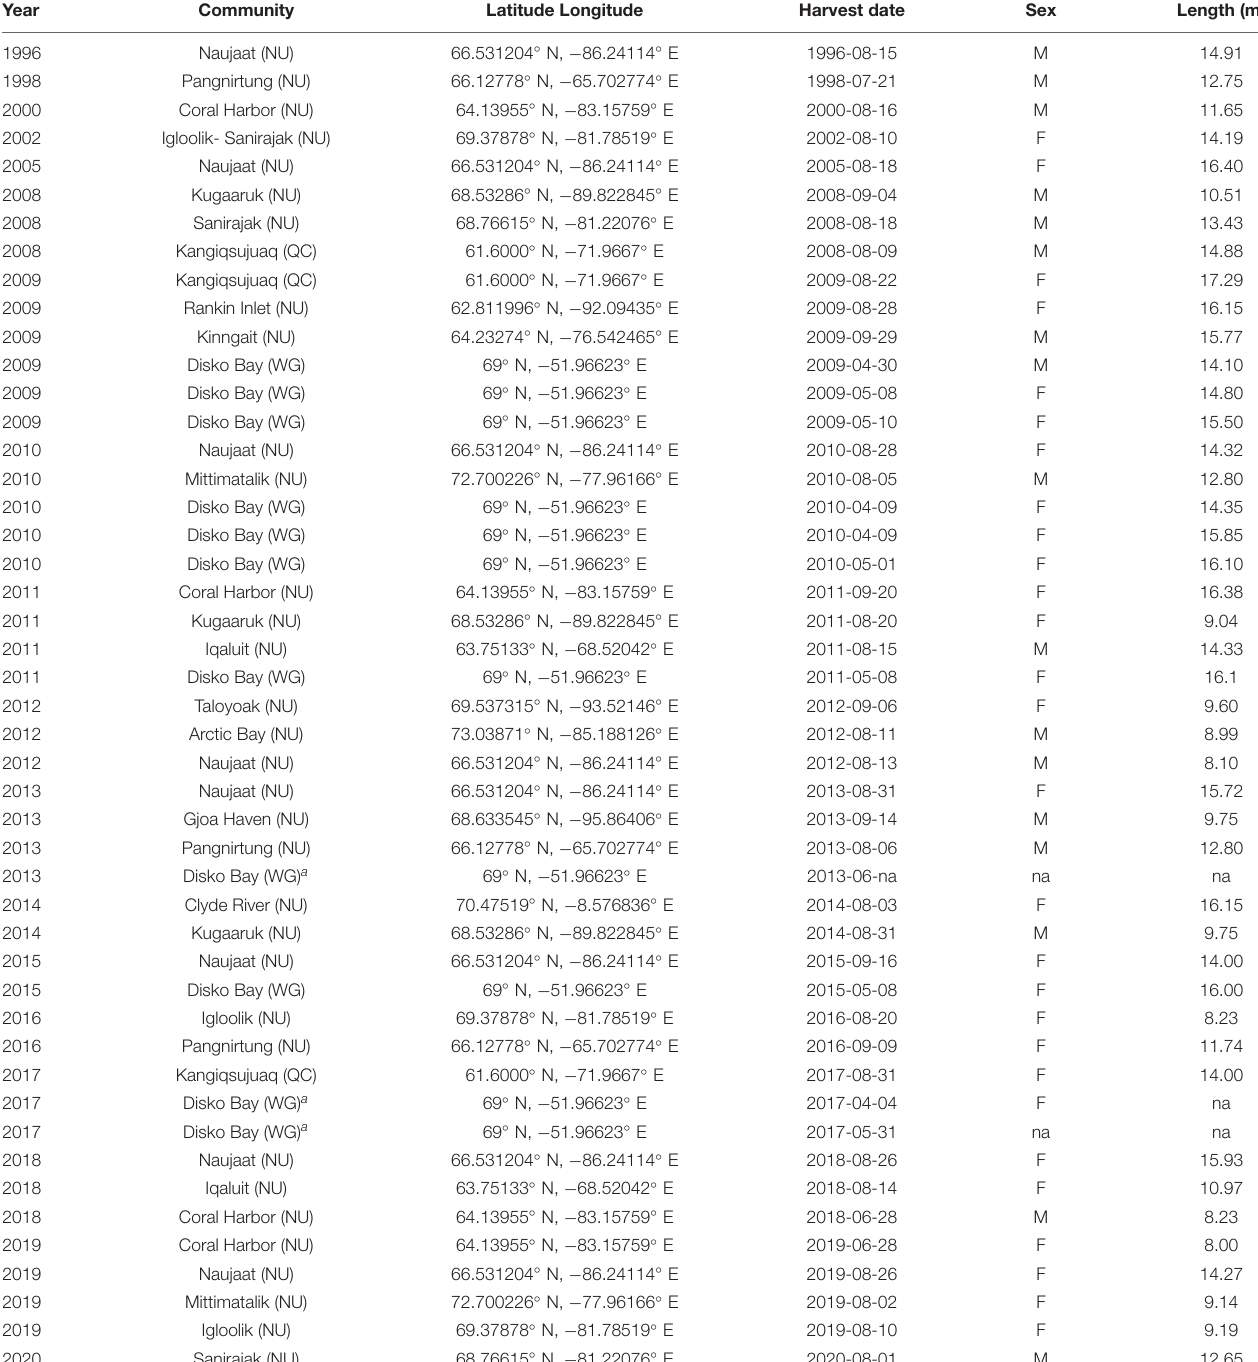
TABLE 2 | Inuit subsistence harvests of ECWG bowhead whales in Nunavut (NU), Nunavik (QC), and West Greenland (WG) since 1996. Year Community Latitude Longitude Harvest date Sex Length